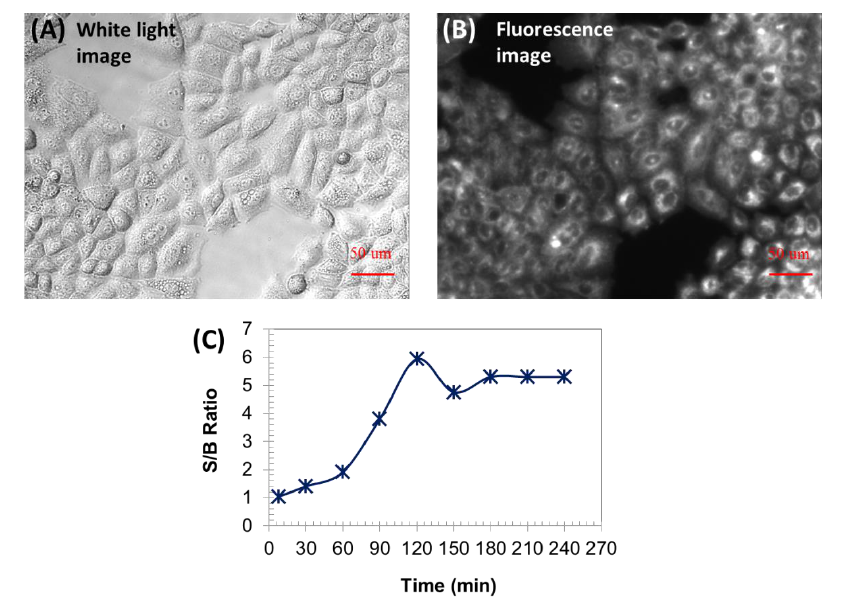
Figure 5. White light ( A ); and fluorescence image ( B ) of living A549 cells loaded with ADP(CA) 2 for 120 min without washing; Excitation filter: 632/22 band-pass filter; Emission filter: 711/25 band-pass filter; Light source energy: 25%; Objective: 20 × ; Exposure time: 3s. ( C ) Signal to background (S/B) ratio as a function of loading time.